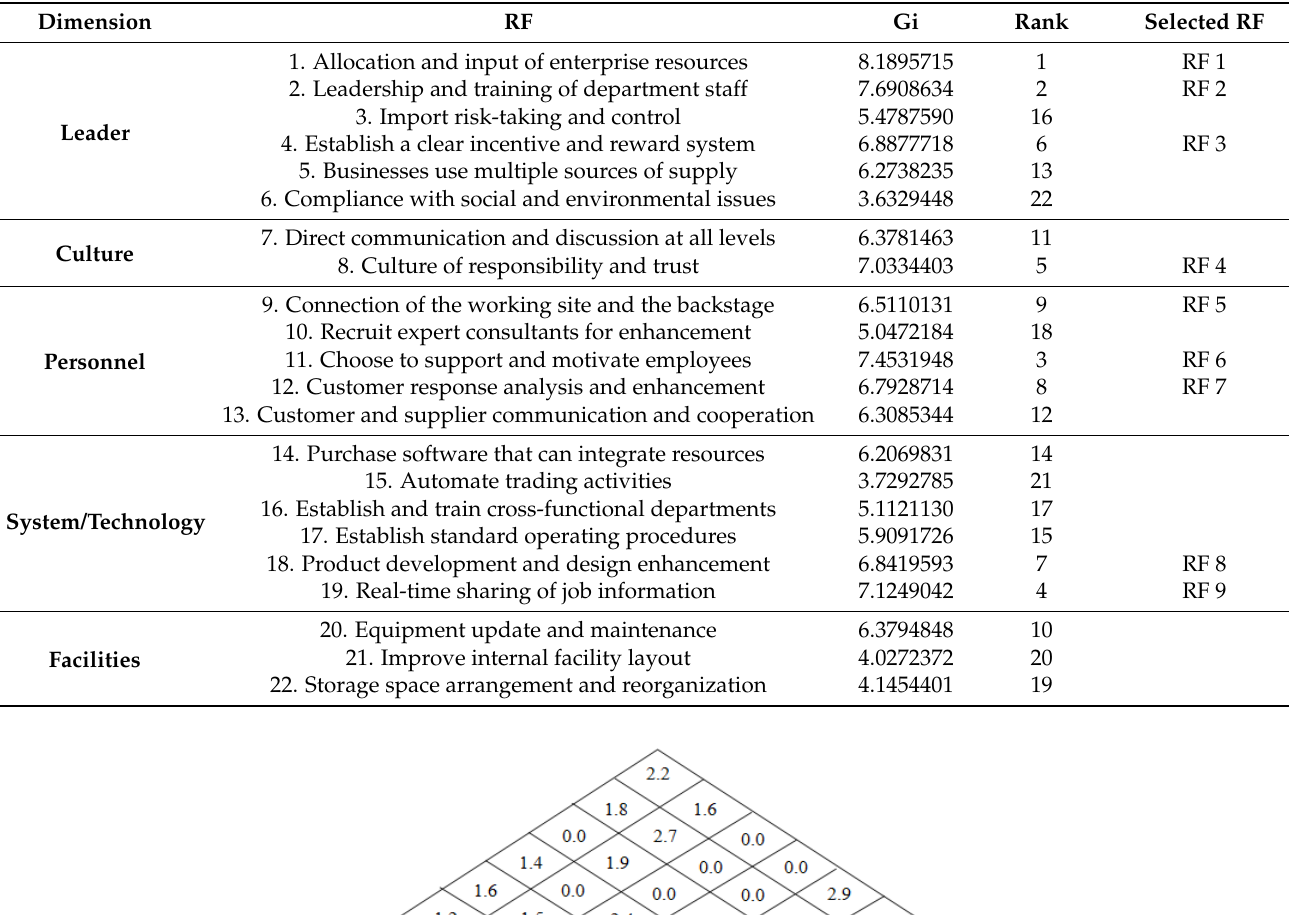
Table 14. Fuzzy Delphi method (FDM) results of key RFs.